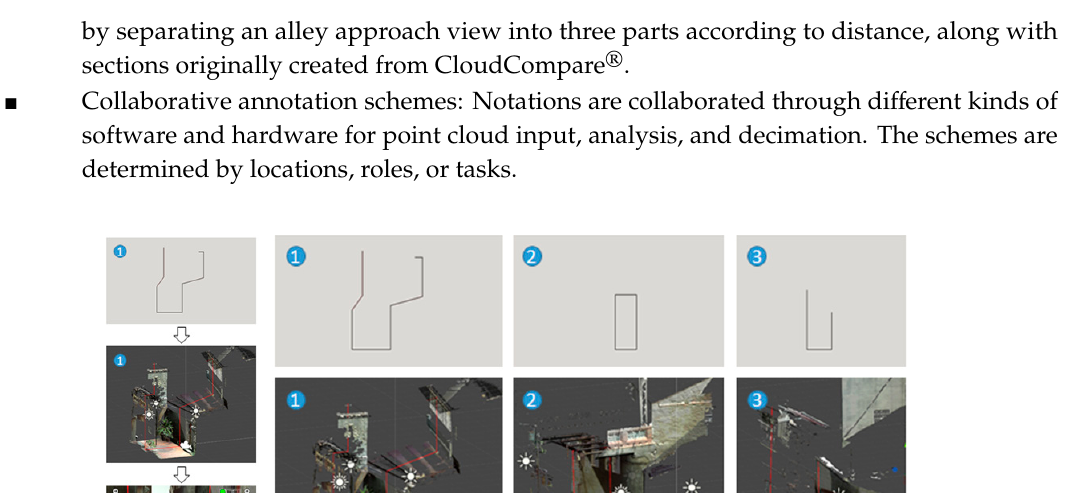
Figure 4. Approaching views of Shih Yih Hall from near to distant ( top ) and from the other direction ( bottom ).